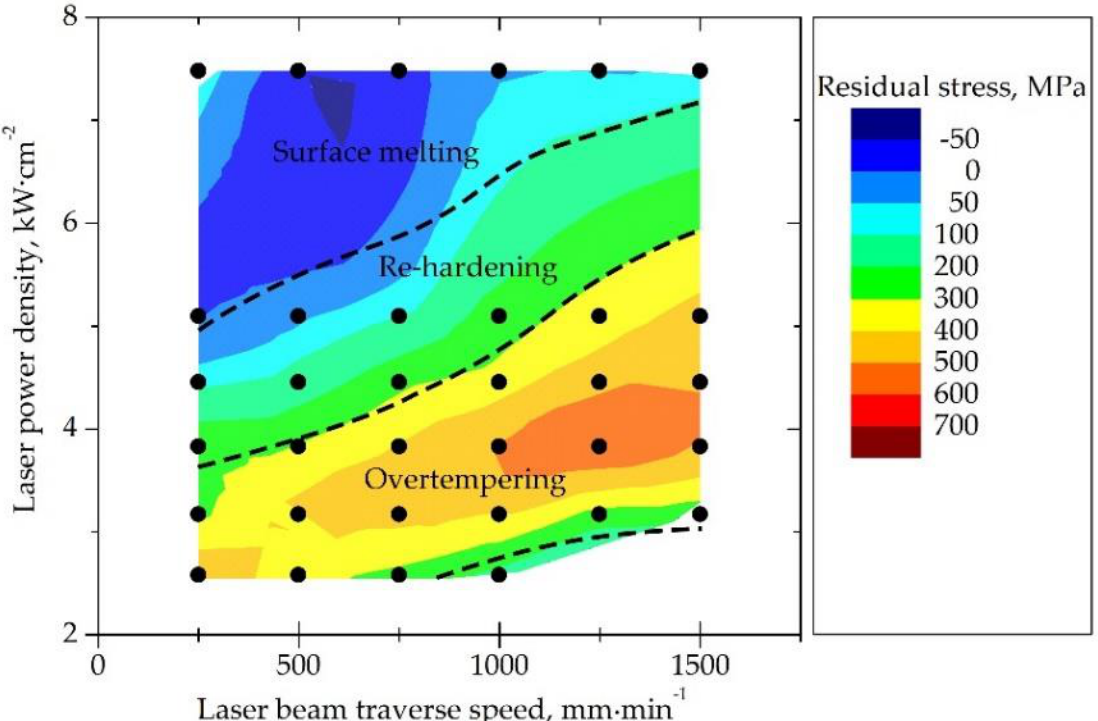
Figure 4. The influence of laser-processing conditions on residual stress values in the irradiated zone of the carburized case-hardened AISI 9310 steel.